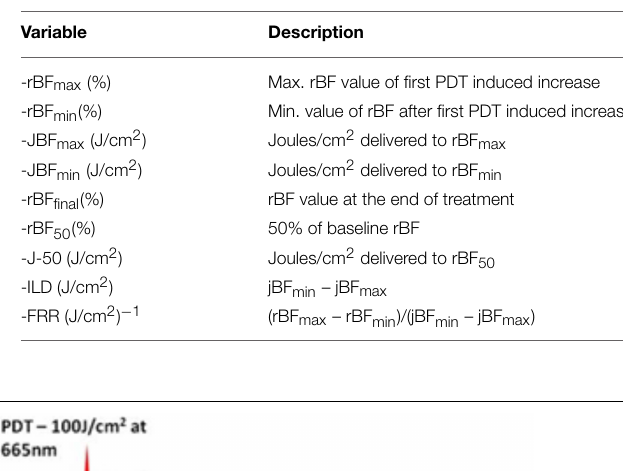
TABLE 1 | Summary of blood flow variables investigated from the continuous blood flow dynamics.